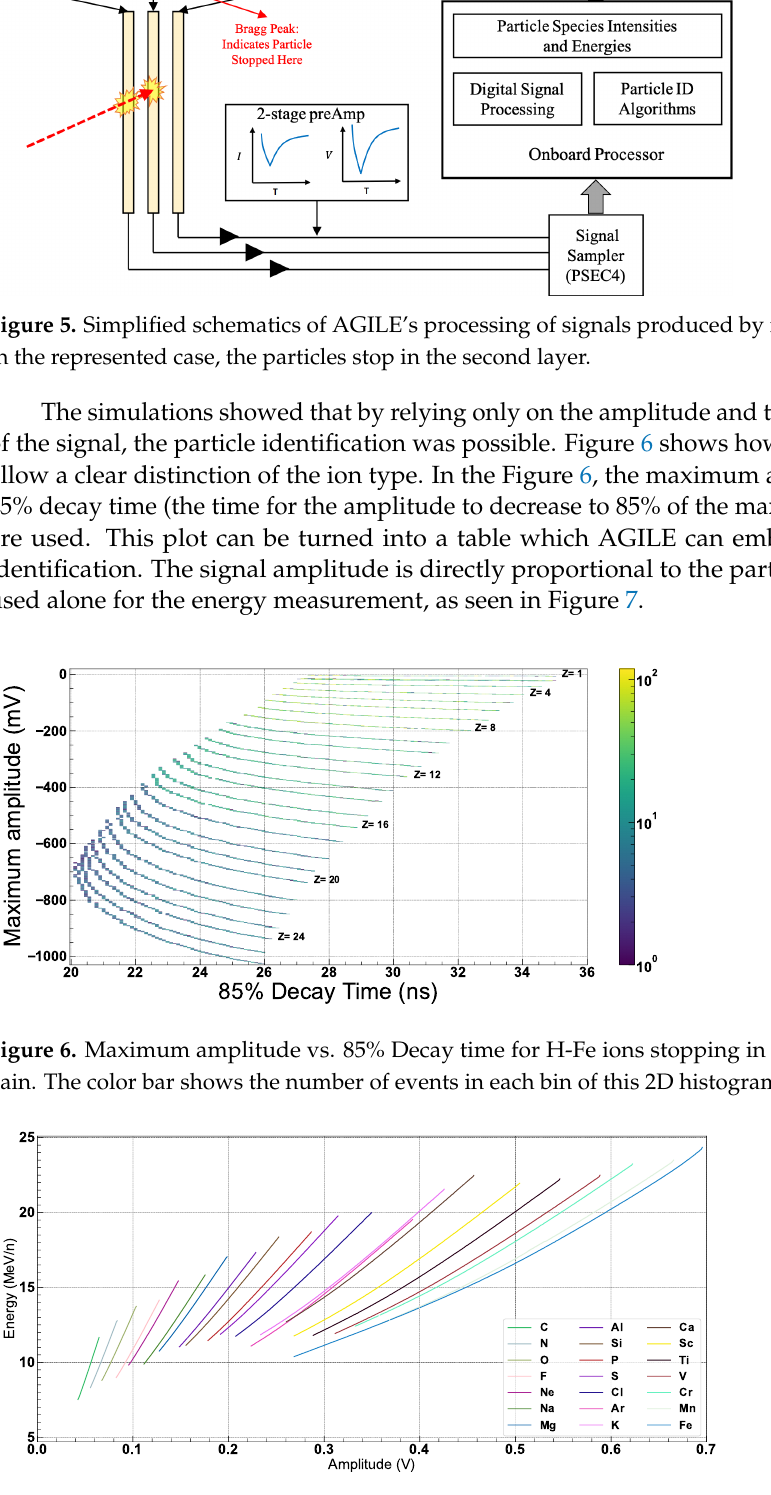
Figure 7. Estimated energy as a function of the measured maximum amplitude in layer 1 when the determination of particle ID is possible. Lines from left to right are for C to Fe. Figure extracted from